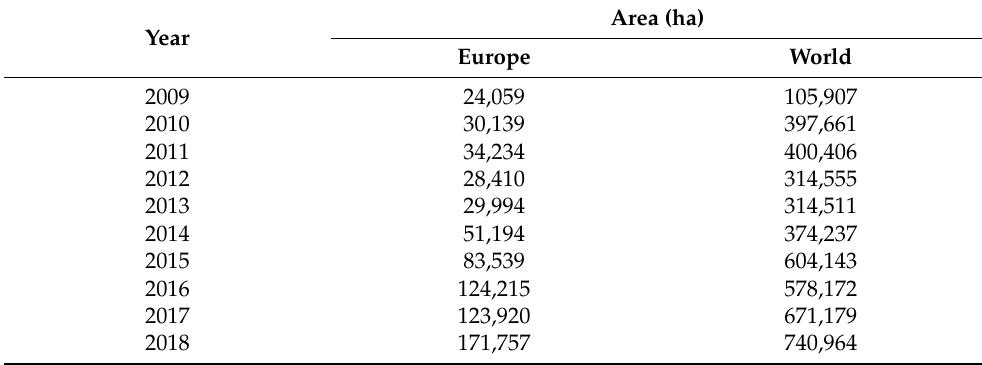
Table 1. Areas under organic soybean cultivation in Europe and the world, in the period from 2009 to 2018